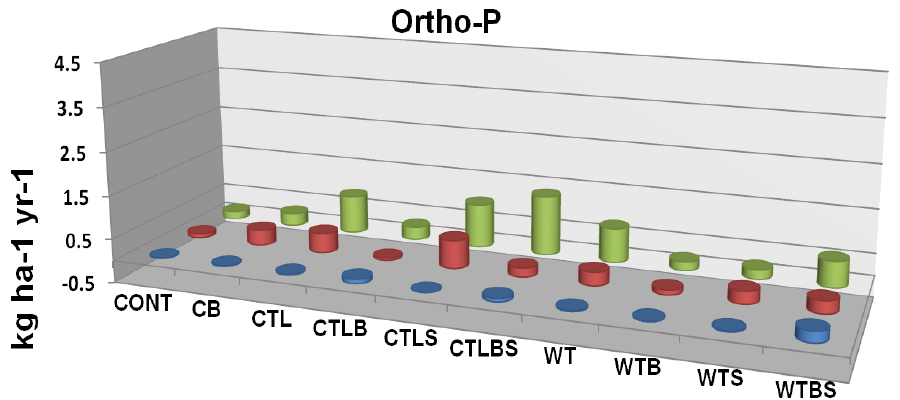
Figure 7B. Ortho-phosphate P leaching flux as related to two forms of mechanical harvest (cut to length and whole tree) two burn treatments and their interaction. Cont = Control Unburned, CB = Control Burn, CTL = Cut to Length Unburned, CTLB = Cut to Length Burned, CTLS = Cut to Length Slash Pile Unburned, CTLBS = Cut to Length Burned Slash Piles, WT = Whole Tree Unburned, WTB = Whole Tree Burned, WTS = Whole Tree Skid Trail Unburned, WTBS= Whole Tree Burned Skid Trail. Although no significant differences were identified there is an apparent trend in response to fire. Adapted from